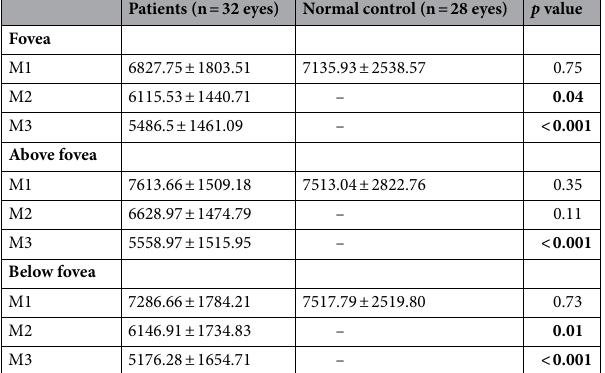
Patients (n = 32 eyes) Normal control (n = 28 eyes) p